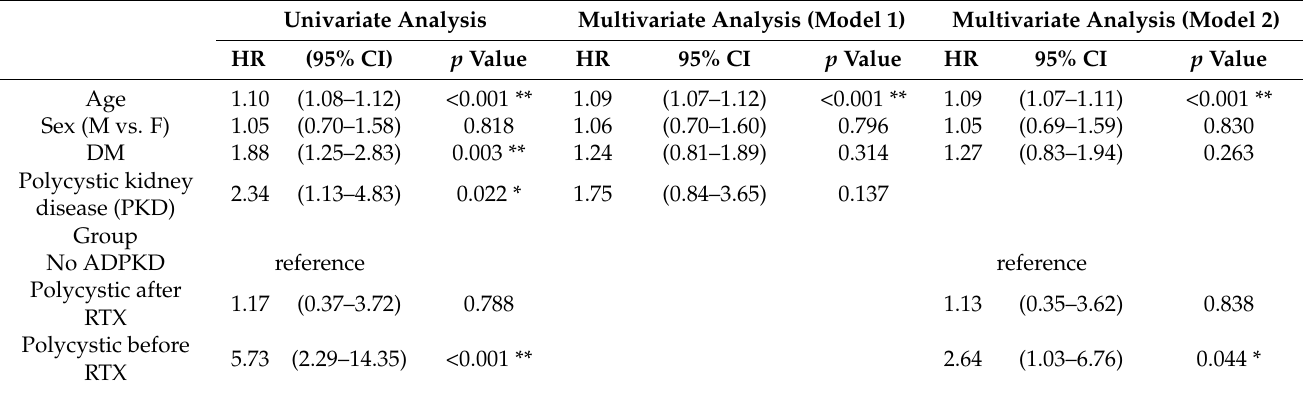
Table 2. Univariate and multivariate Cox regression models for the causes of death in RTx. Univariate Analysis Multivariate Analysis (Model